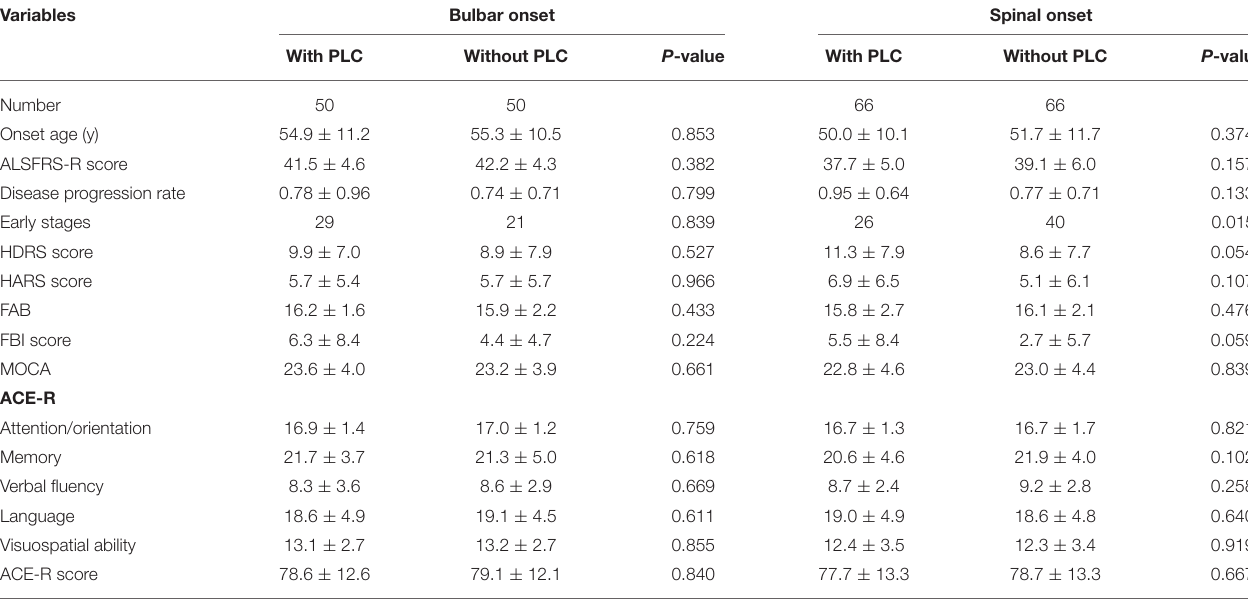
TABLE 4 | Comparison of cognitive features at baseline between patients and matched pairs groups.